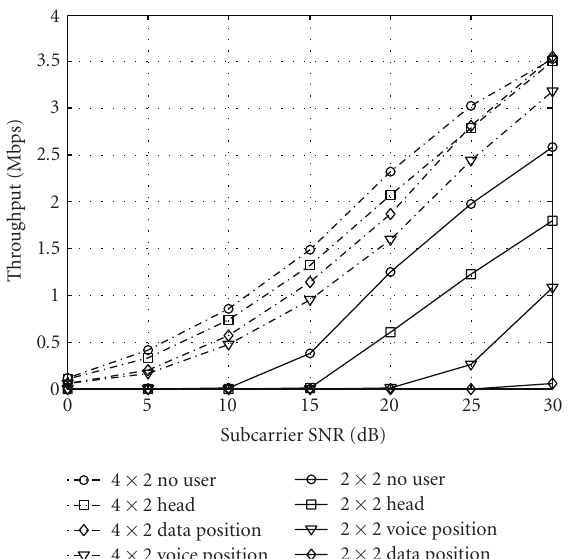
Figure 16: Comparison of spatial multiplexing and transmit diversity performance in (a) FS, (b) H, (c) HH, and (d) D for a 4 × 2 MIMO